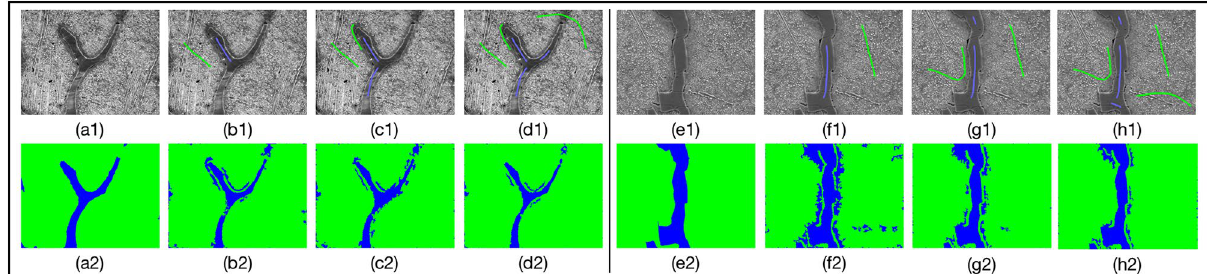
Figure 2. Training process of images in group B. ( a1 , e1 ) are the original images of group B. ( a2 , e2 ) are the ground truth. ( b1 , c1 , d1 ), ( f1 , g1 , h1 ) are the training processes for ( a1 ) and ( e1 ), respectively. ( b2 , c2 , d2 , f2 , g2 , h2 ) are their results corresponding with per training round.